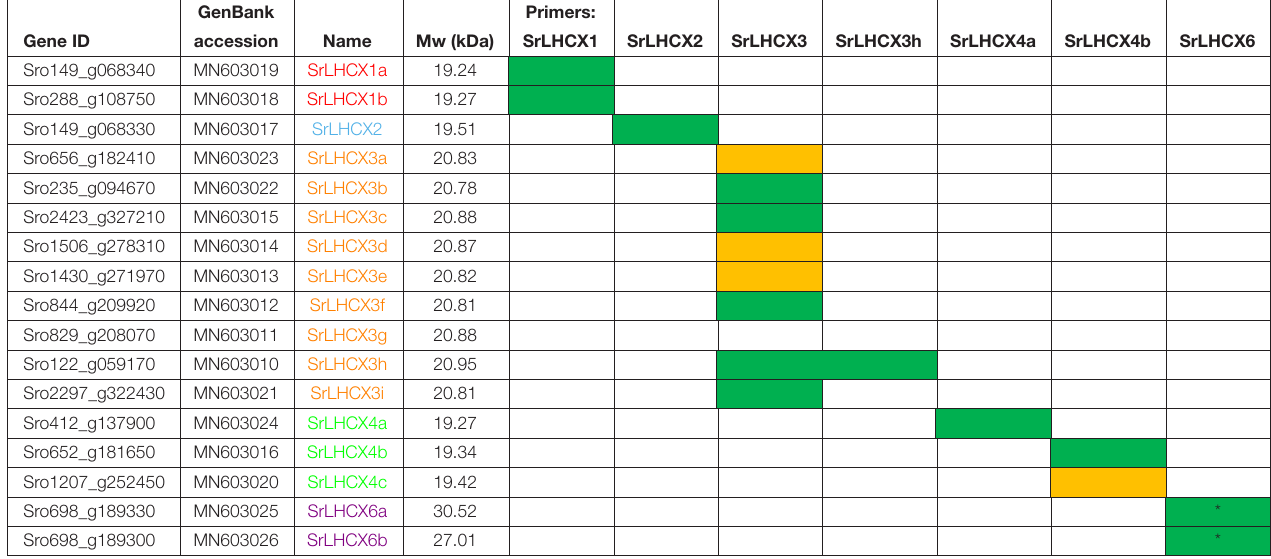
TABLE 1 | Gene ID, GenBank accession number, Name, calculated molecular weight (Mw) and primer specificity. Name colours match the clade colours used in Figure 1 . GenBank Primers: